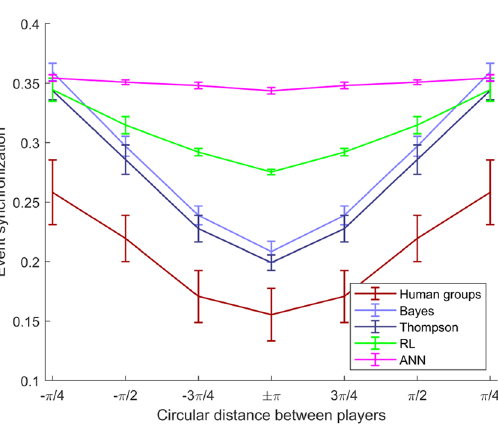
Figure 4. Event synchronization. Average event synchronization across all pairs of players as a function of the circular distance of the actual movement direction between players. Error bars indicate 99% confidence